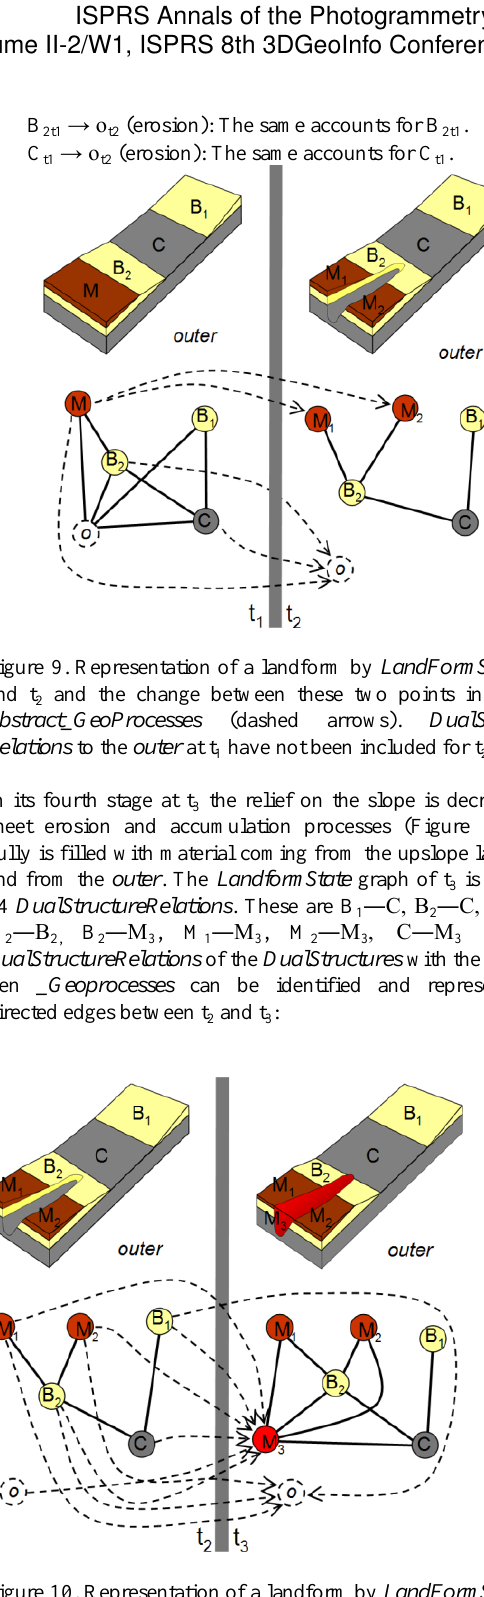
Figure 10. Representation of a landform by LandFormState at t 0 and t 1 and the change between these two points in time by Abstract_Geoprocesses (dashed arrows). DualStructure- Relations to the outer has not been included. B 1t2 → M 3t3 (erosion, fall, accumulation): Material may be washed into the gully and fill it or just break down from the wall of the